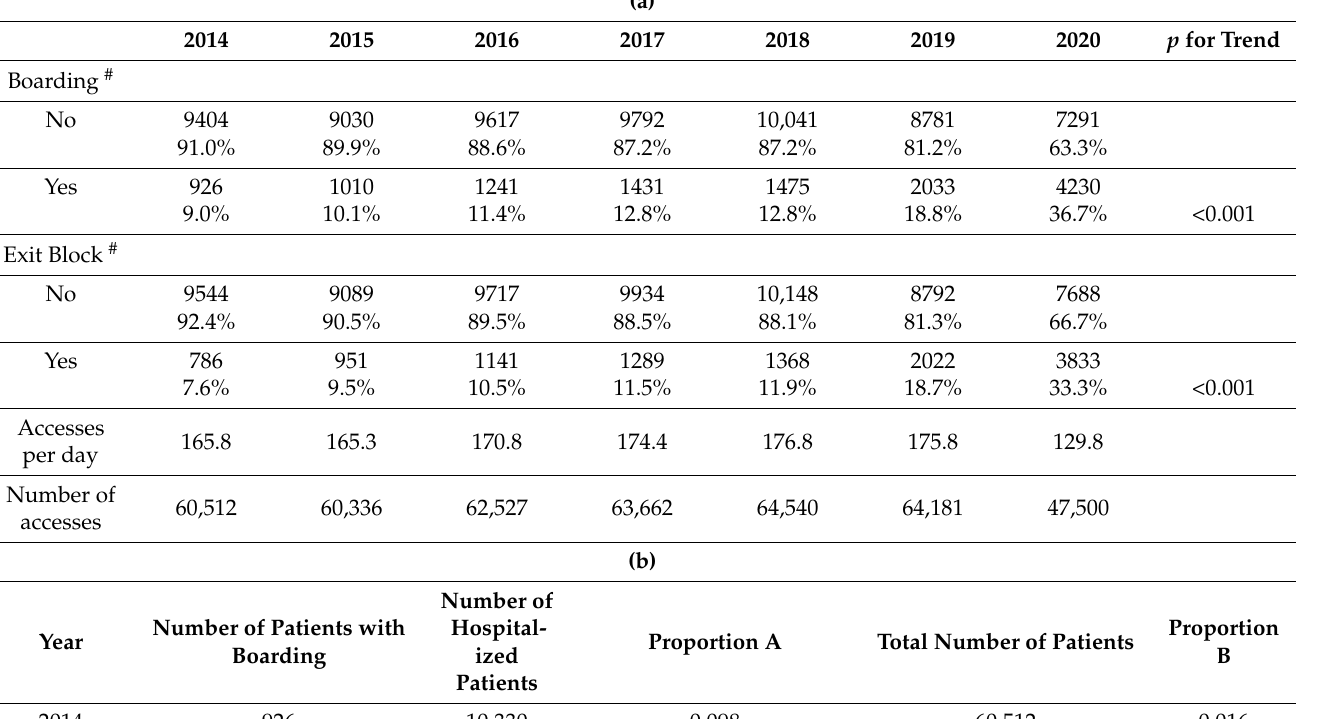
Table 4. ( a ) # Proportion of boarding and exit block (calculated only on hospitalized patients) from 2014 to 2020; ( b ) Table + Figure. Evolution of boarding from 2014 to 2020; ( c ) Table + Figure. Evolution of Over Triage (OT) from 2014 to 2020; ( d ) Table + Figure. Evolution of Under Triage (UT) from 2014 to 2020.